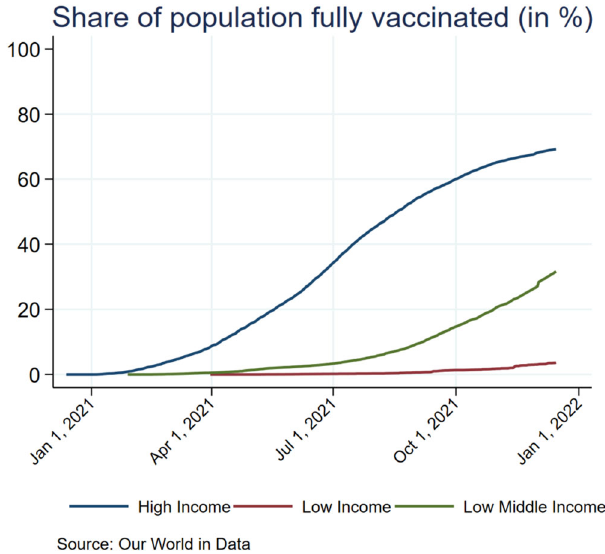
Fig. 1 The share of population fully vaccinated. The share of the population fully vaccinated against COVID-19 across high-, lower middle-, and low-income countries (source: Our World in Data, https://github.com/